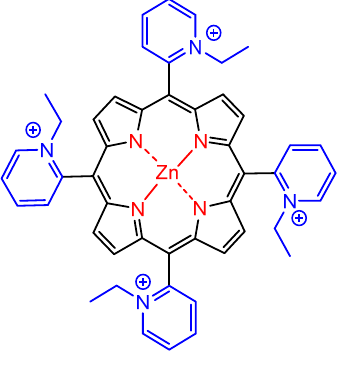
Figure 9. Molecular structure of zinc(II) tetra-cationic porphyrin demonstrating effective antimicrobial photodynamic (aPDT) activity against Leishmania braziliensis , by Andrade et al. [42].